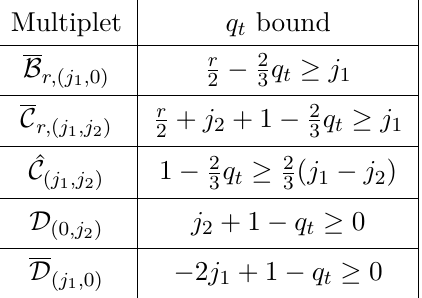
Table 17. Restrictions imposed on the u (1) t representations implied by the existence of the Hall- Littlewood limit of the index. In order that a multiplet contributes to the Hall-Littlewood index it must have j = 0 and saturate the 1